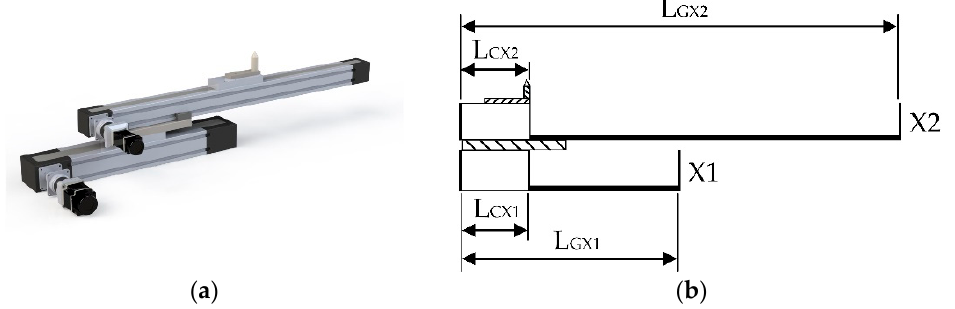
Figure 18. Telescopic servo axis. ( a ) 3D view; ( b ) MMCS view.